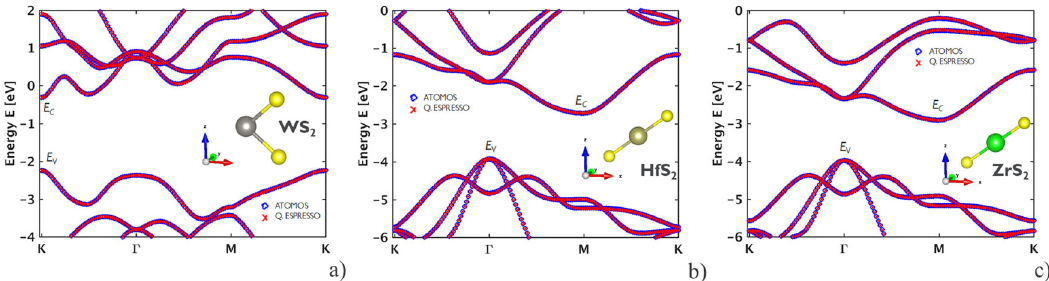
Fig. 2 Band structure computed with QUANTUM ESSPRESSO using plane-wave DFT and with ATOMOS using the Wannierized Hamiltonian. Band structure for a a monolayer WS 2 (2H-phase) b a monolayer HfS 2 (1T-phase) and c a monolayer ZrS 2 (1T-phase). The insets also show the atomic structure and chosen cartesian-axes directions for the various